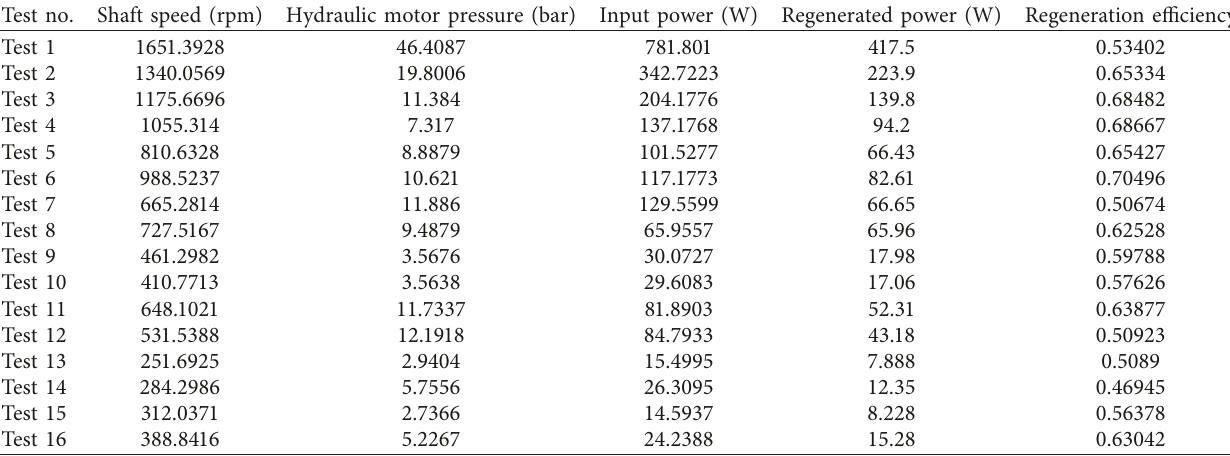
Table 9: Summary of simulation